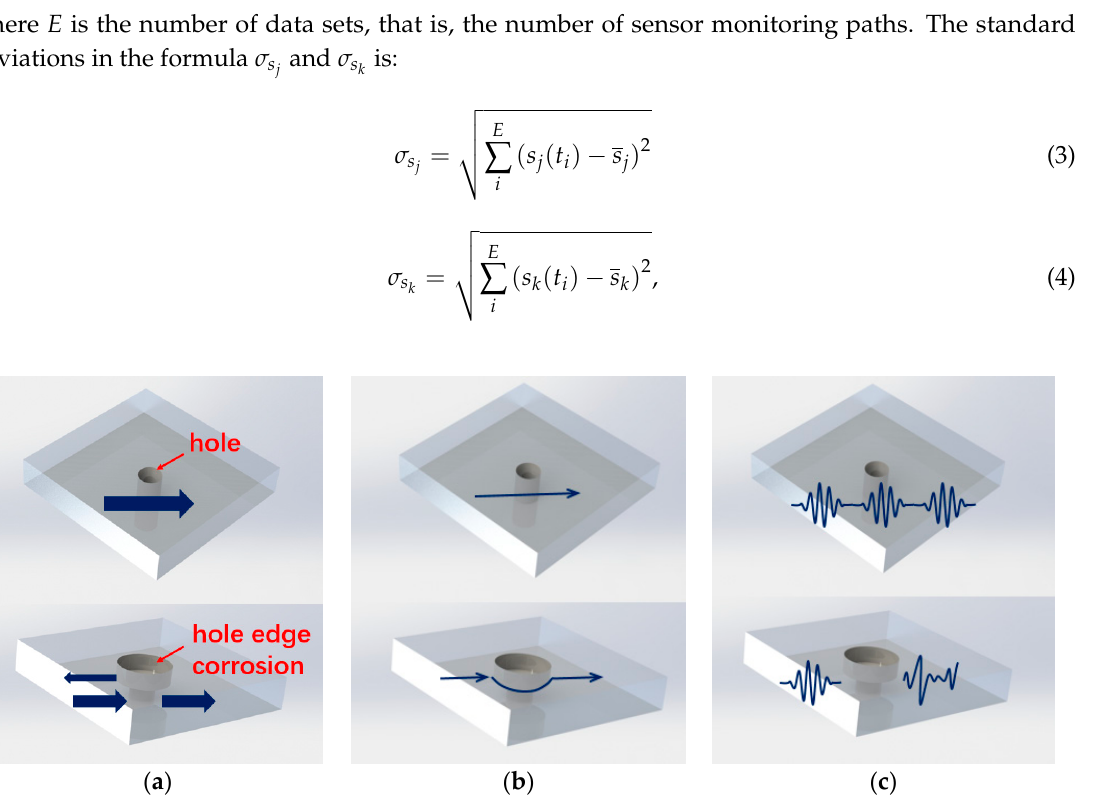
Figure 2. Illustration of changes for Lamb waves passing through a hole-edge corrosion. ( a ) Signal maximum amplitudes, ( b ) Signal phase, and ( c ) Signal time series.